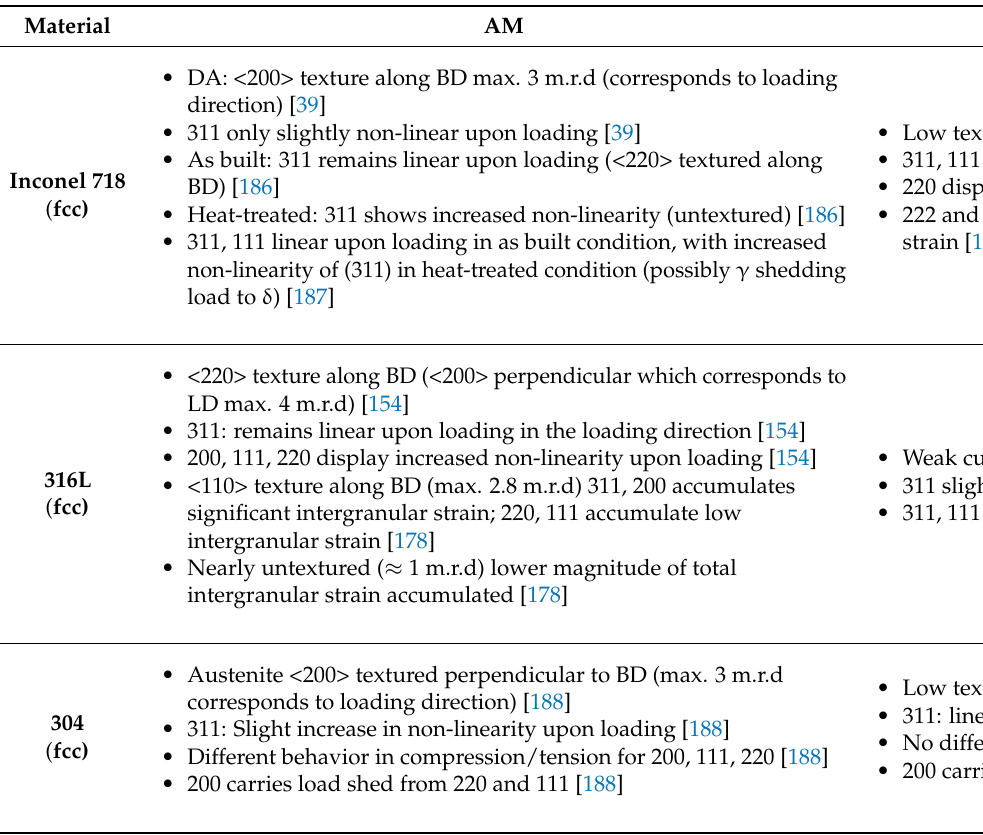
Table 5. Material dependent selection of Lattice planes for RS determination in laser-based